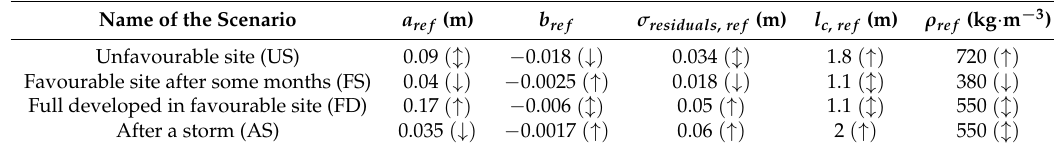
Table 4. Thickness and density parameters of each reference scenario of bio-colonisation.